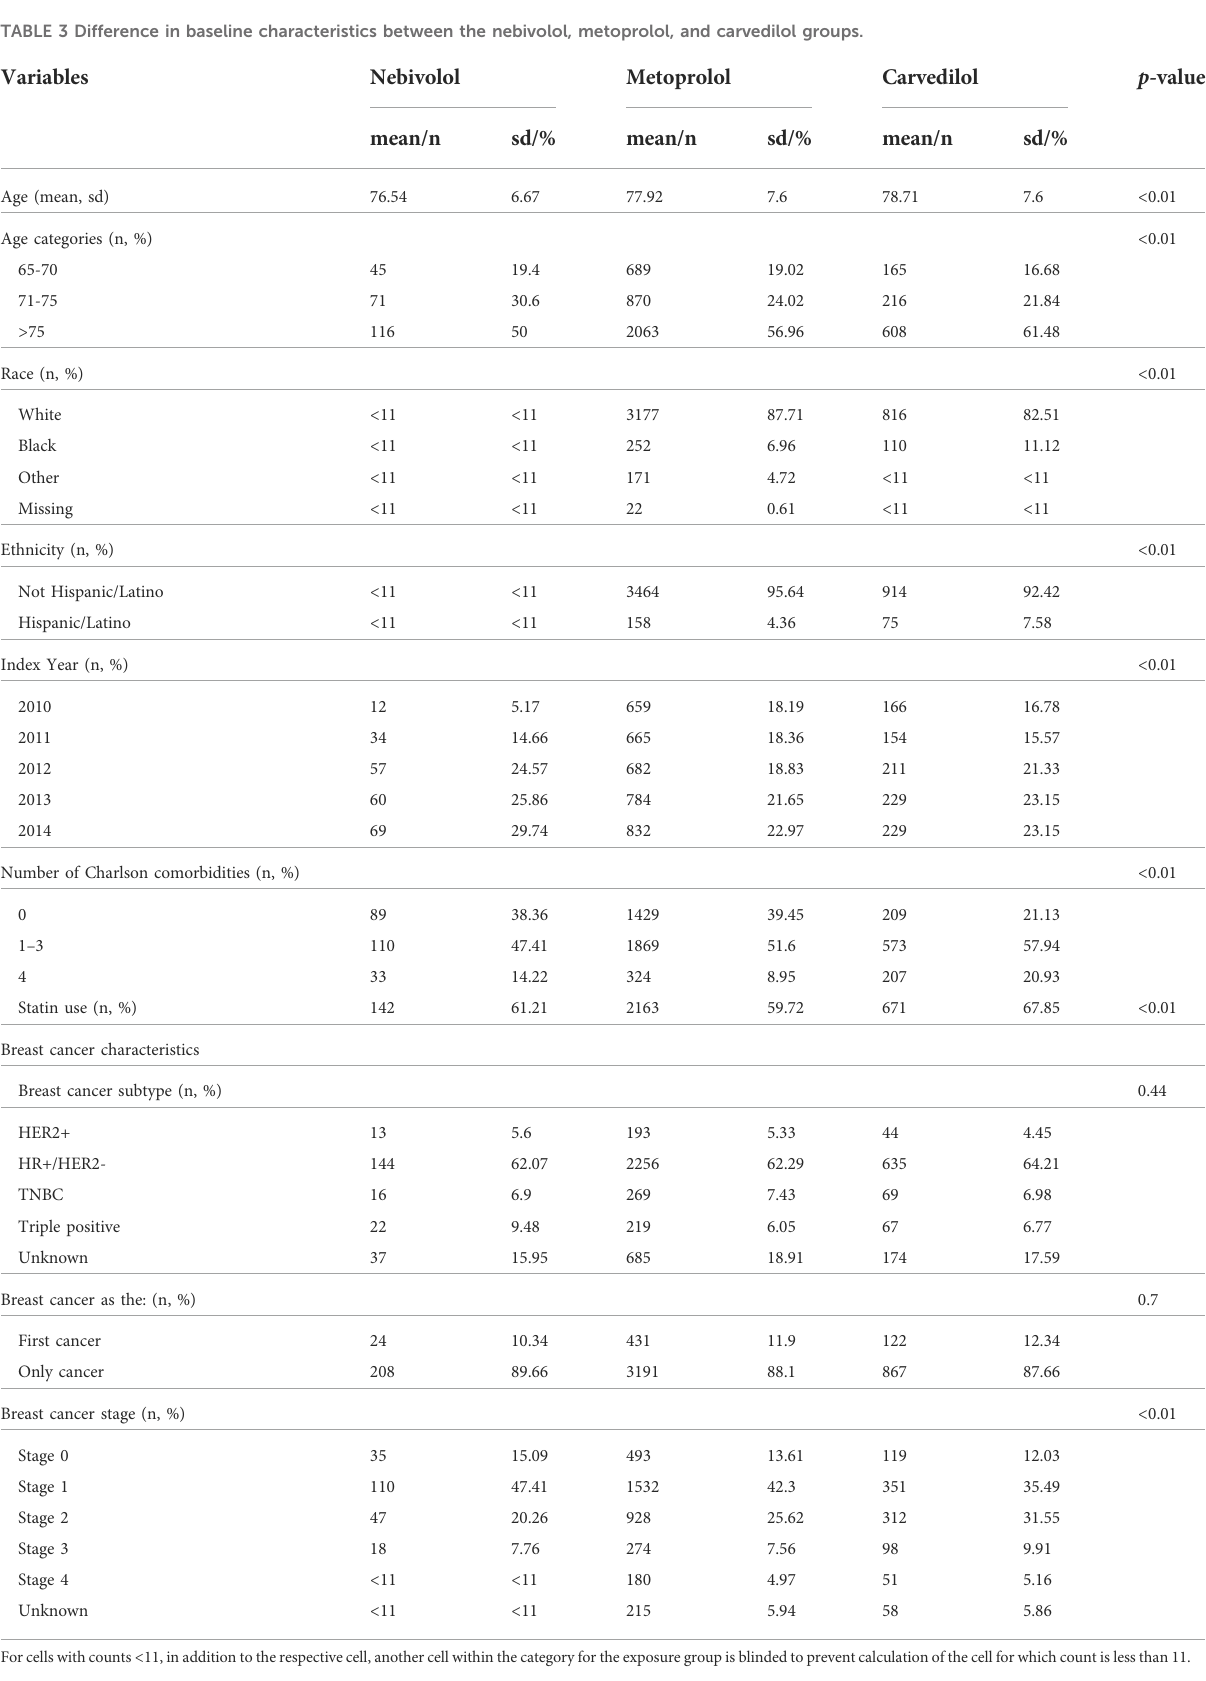
TABLE 3 Difference in baseline characteristics between the nebivolol, metoprolol, and carvedilol groups. Variables